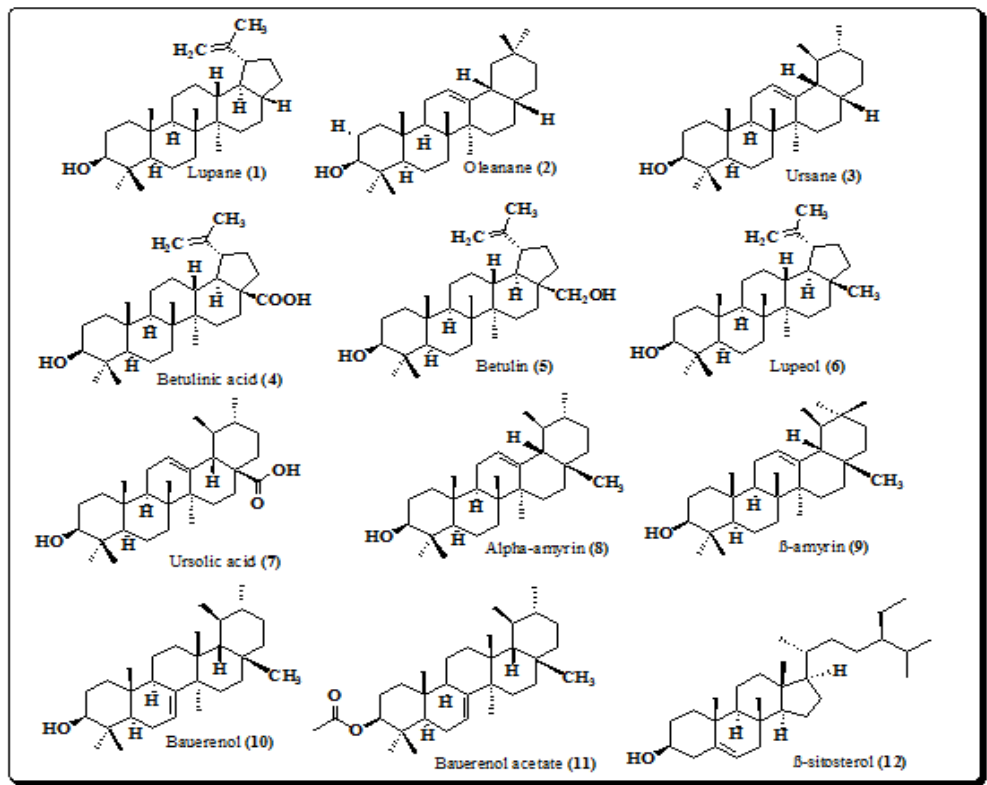
Figure 2. Structures of pentacyclic triterpenoids and phytosterol from E. laevis ( 1 – 12 ).